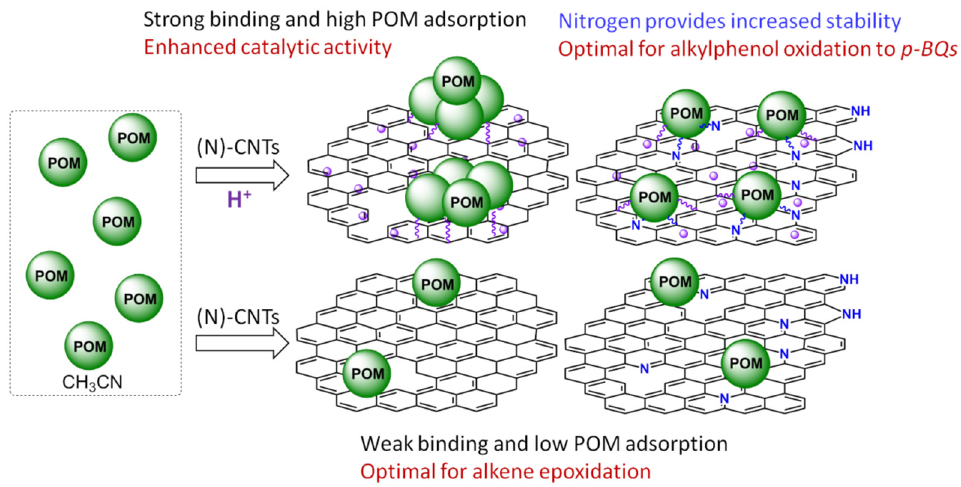
Figure 16. A simplified representation of the effects of protons and N-doping on POM adsorption on CNTs and catalytic properties of immobilized POM.